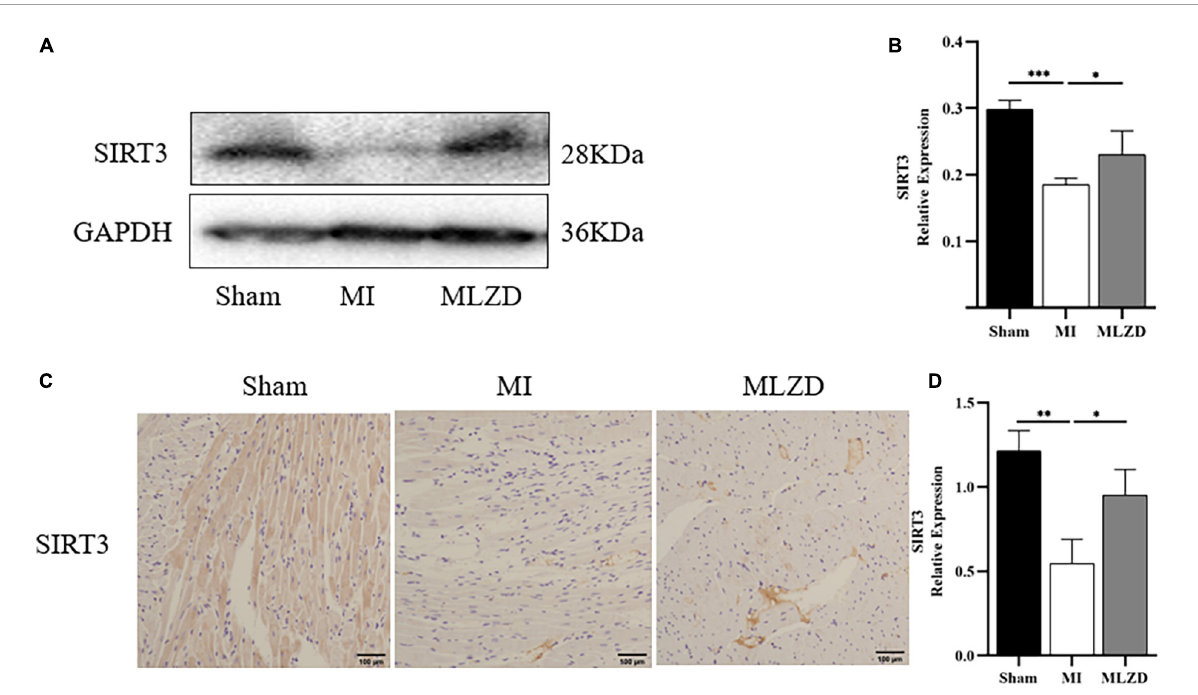
FIGURE7 Modified Linggui Zhugan Decoction (MLZD) promoted SIRT3 expression in cardiac tissue. (A,B) Relative expression of SIRT3 detected via immunoblot analyses. The widths of the images have been compressed at a ratio of 1:0.6. n = 4 per group. (C,D) Immunohistochemical analysis for detecting SIRT3, n =3 per group, scale bar = 100 µ m. Data are represented as mean ± standard deviation ( x ± s); ∗ P < 0.05, ∗∗ P < 0.01, ∗∗∗ P <